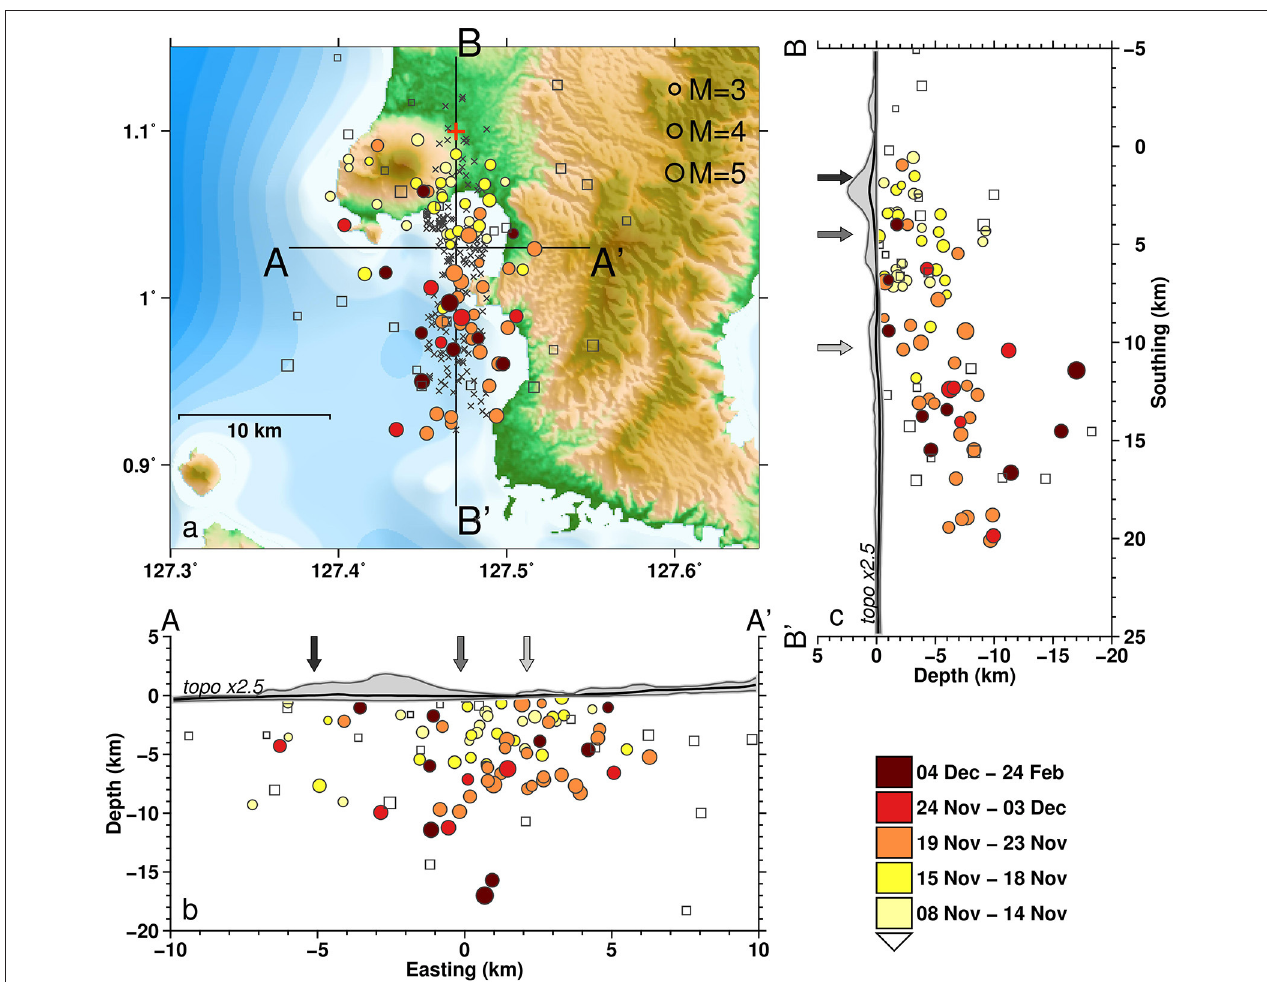
FIGURE 3 | Map view and cross-sections of the relocated seismicity during the seismic swarm around Jailolo. (a) Map view of the region around Jailolo, with circles indicating the 69 earthquakes that occurred during the swarm activity and are relocated using the regional network. The color code refers only to the circles and has uneven time windows, which are labeled in the color palette, from November 2015 to February 2016. Empty squares are the events that occurred before 8 November 2015. AA’ and BB’ represent the two profiles used to project the seismicity at depth as represented in panels (b,c). Gray crosses indicate single-station locations, which are randomly scattered at 2km for visibility. The red plus symbol on the BB’ line is the origin of the Cartesian coordinate system used in panels (b,c) and in Figures 8 , 9 . (b) Depth projection of the seismicity along the east–west AA’ profile. The gray shaded area represents the topography swath profile measured along AA’ with a width of 10km; the dark solid line is the average height and the upper and lower solid gray lines are the maximum and minimum height across the profile. Arrows indicate the positions of surface cracks as shown in Figure 2 and are color-coded according to their longitude in (a) . Topographic profile is magnified as indicated. (c) Same as panel (b) but for the north–south BB’